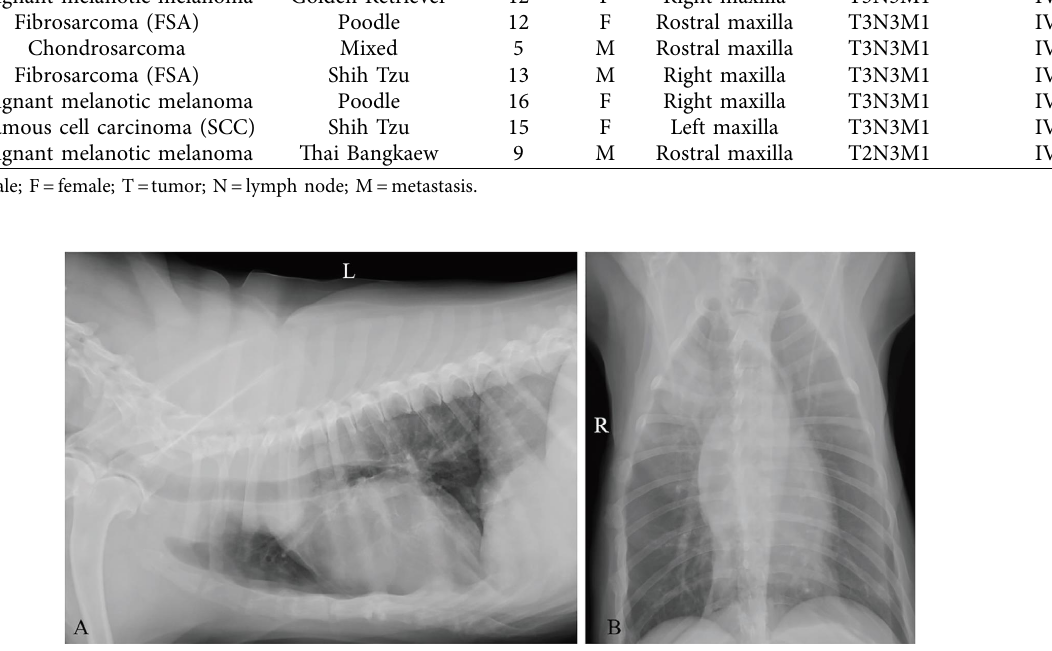
Figure 3: Te thoracic radiography of the oral tumor-bearing dog with lung metastasis. Te left lateral view of thoracic radiography (a) and the ventrodorsal (VD) view of thoracic radiography (b).